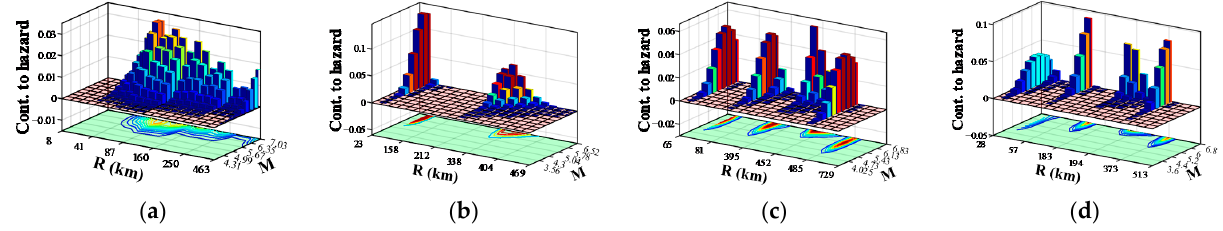
Figure 9. Disaggregation plot for most contributing earthquake range selection from four seismic source models in Korea: ( a ) model A; ( b ) model B; ( c ) model C; ( d ) model